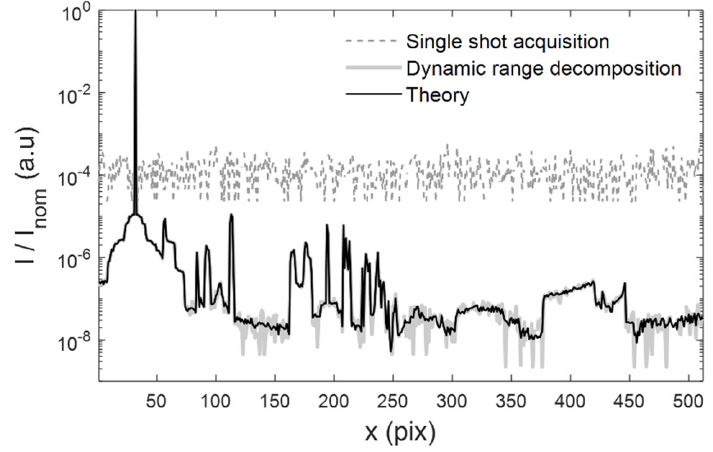
Figure 13. Profile along x (at y = 256) of the signal when the instrument is illuminated by a point-like source at the field ( i,j ) = (256,32). The continuous curve provides the theoretical profile that would be obtained for a noise-free detector. The case of a detector with a noise modeled as per Equation (13) is also shown, considering a single shot acquisition or dynamic range